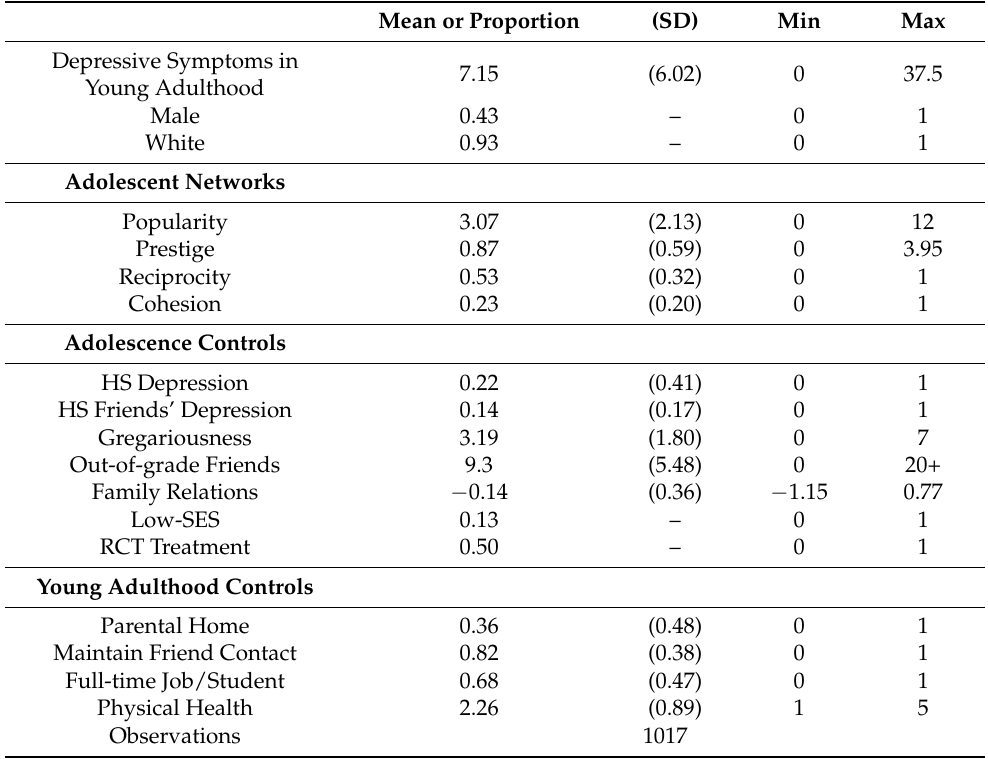
Table 1. Descriptive statistics of analytic sample in PROSPER